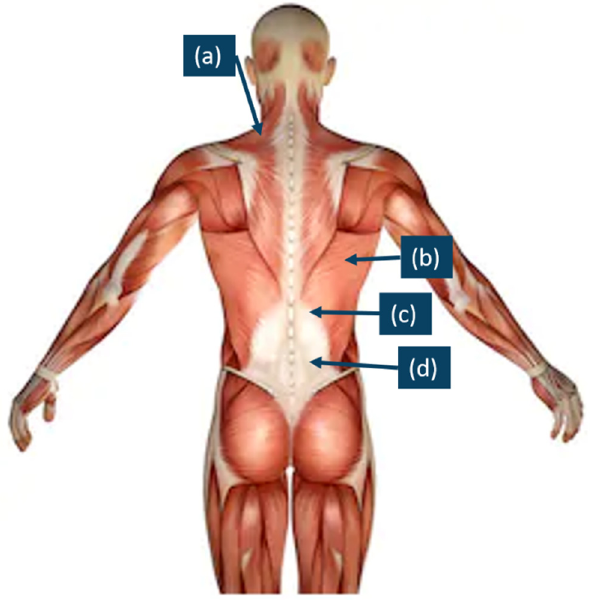
Figure 2. Electrode placement. Upper trapezius (TRAP) (a), latissimus dorsi (b), erector spinae— thoracic (c), and erector spi-nae—lumbar (d).